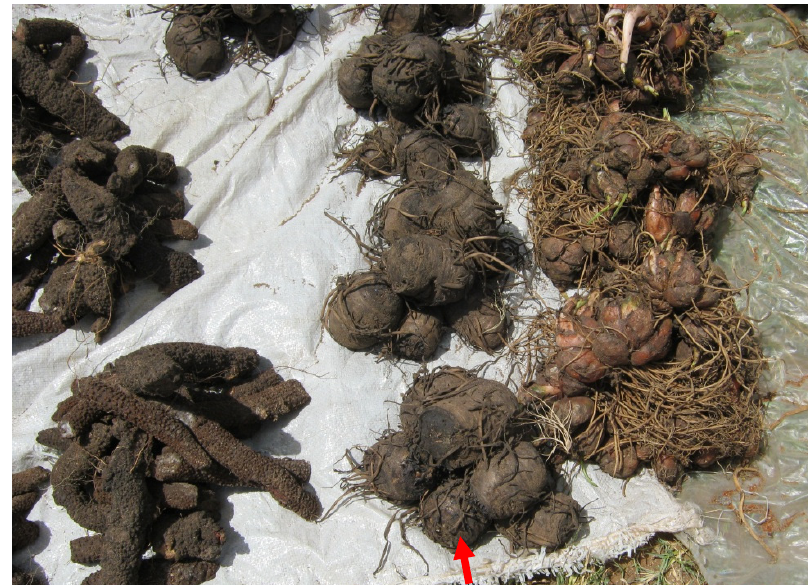
Figure 3. Hypoxis hemerocallidea corms displayed (red arrow at middle bottom of the picture) at an informal market in northern KwaZulu-Natal, South Africa, with other medicinal plants.